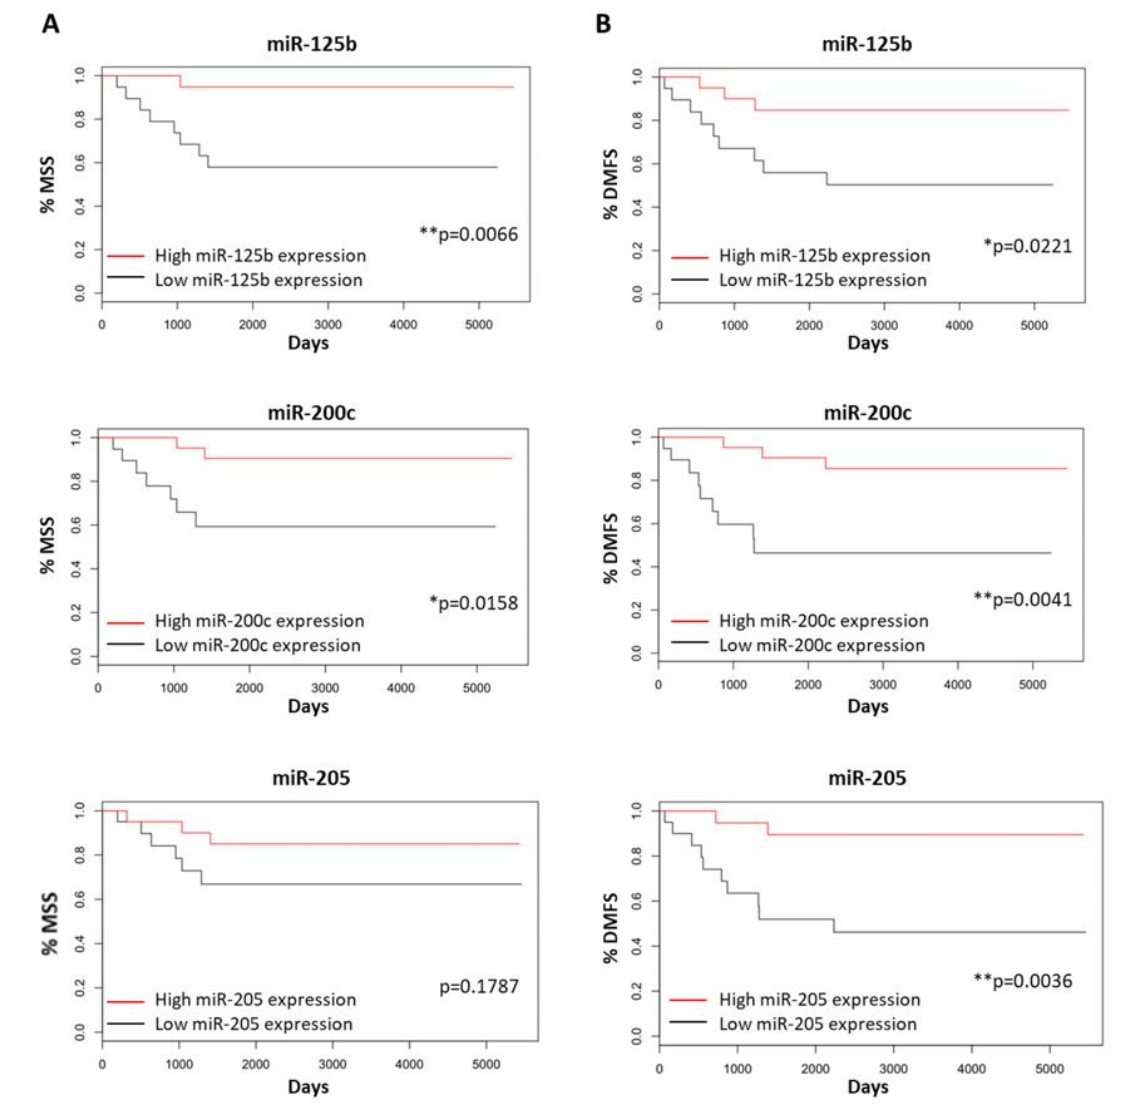
Figure 7. Kaplan–Meier curves for MSS and DMFS of BRAF mutated primary melanoma patients depending on miR-125b, miR-200c and miR-205 expression being below (black) or over (red) their corresponding median expression values. Influence of miR-125b, miR-200c and miR-205 expression affecting ( A ) MSS and ( B ) DMFS of patients, respectively. Significant at * p -value < 0.05, ** p -value < 0.01.